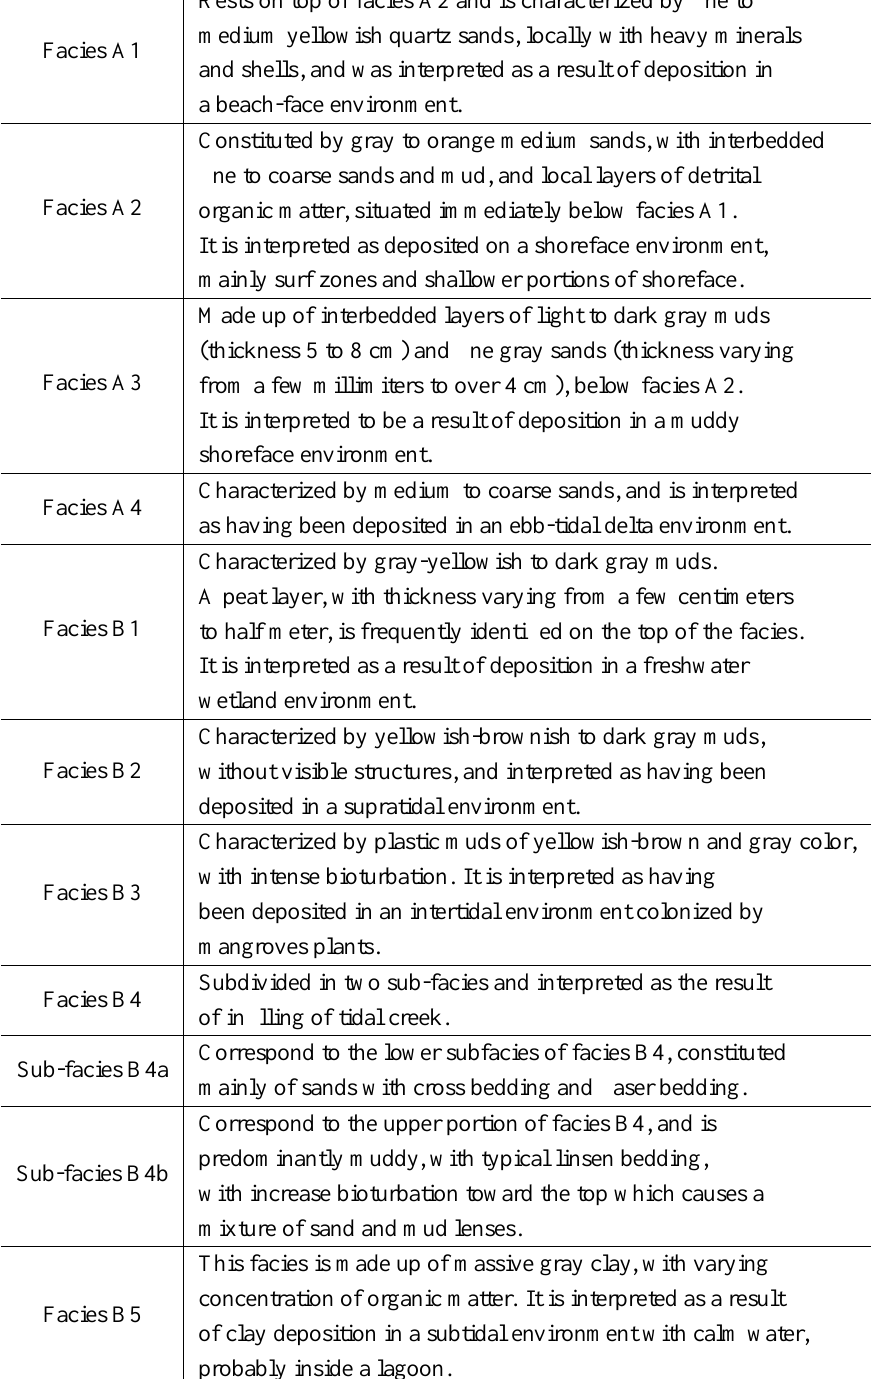
Facies association detected on Caravelas region (Andrade et al.